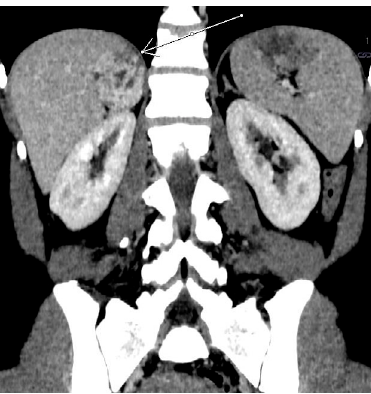
Figure 12. Adrenal cortical carcinoma. Abdomen CT, longitudinal cross-section. On admission, the physical examination, as well as hormonal evaluation, revealed no clinically significant abnormalities (Table 1). Due to ambiguous radiologic character- istics, the patient qualified for a unilateral adrenalectomy. Based on the postoperative histopathological examination of specimens, an adrenocortical carcinoma (ACC) was diag- nosed (Weiss score of 3 points) (Figure 13). The imaging examinations during the five-year follow-up showed no signs of